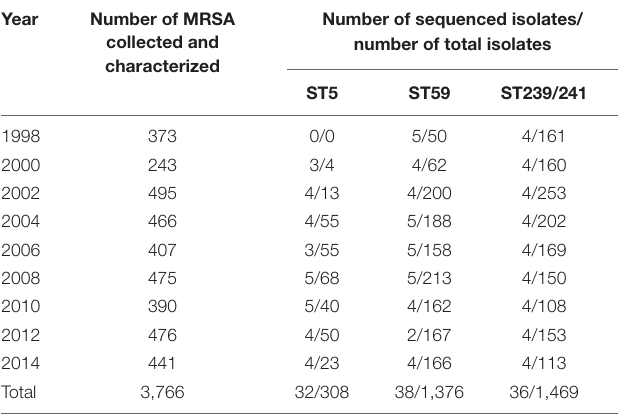
TABLE 1 | Distribution of methicillin-resistant Staphylococcus aureus (MRSA) isolate total numbers, numbers of ST5, ST59, and ST239/241 isolates in different years of surveillance, and numbers of isolates for whole-genome sequencing analysis selected from the Taiwan Surveillance of Antimicrobial Resistance program collection.